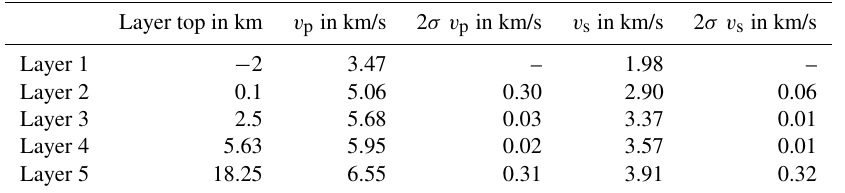
Table 1. ASZmod1 with corresponding error estimates based on 2 σ .